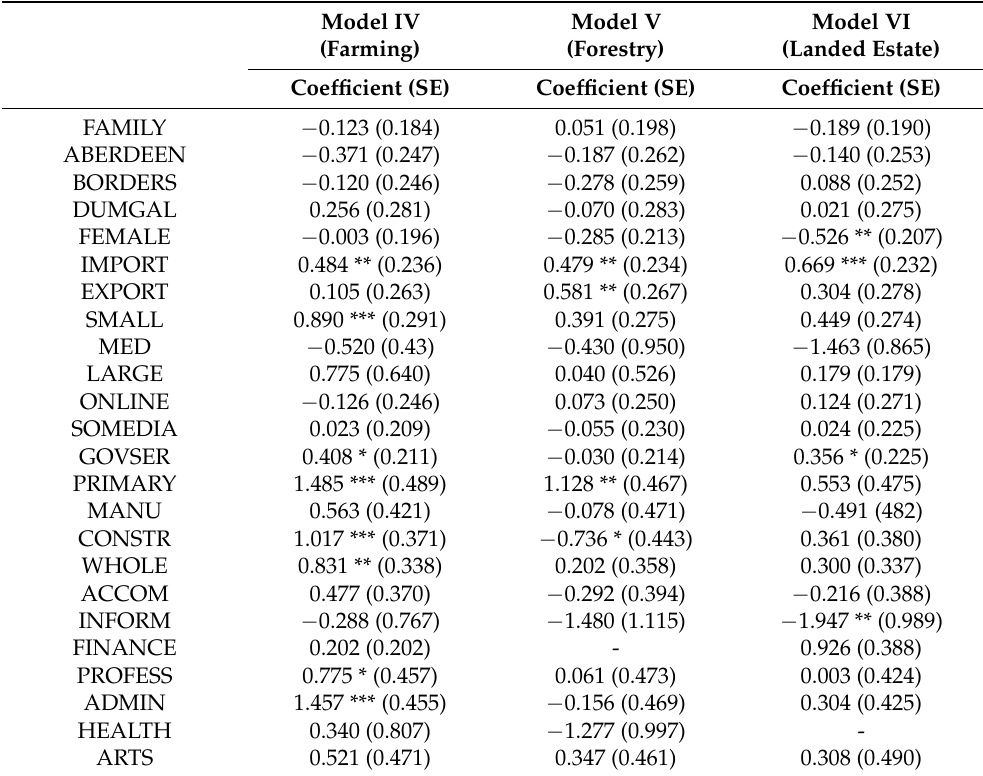
Table 3. The key determinants of a connection with land-based industry among non-land-based businesses in rural